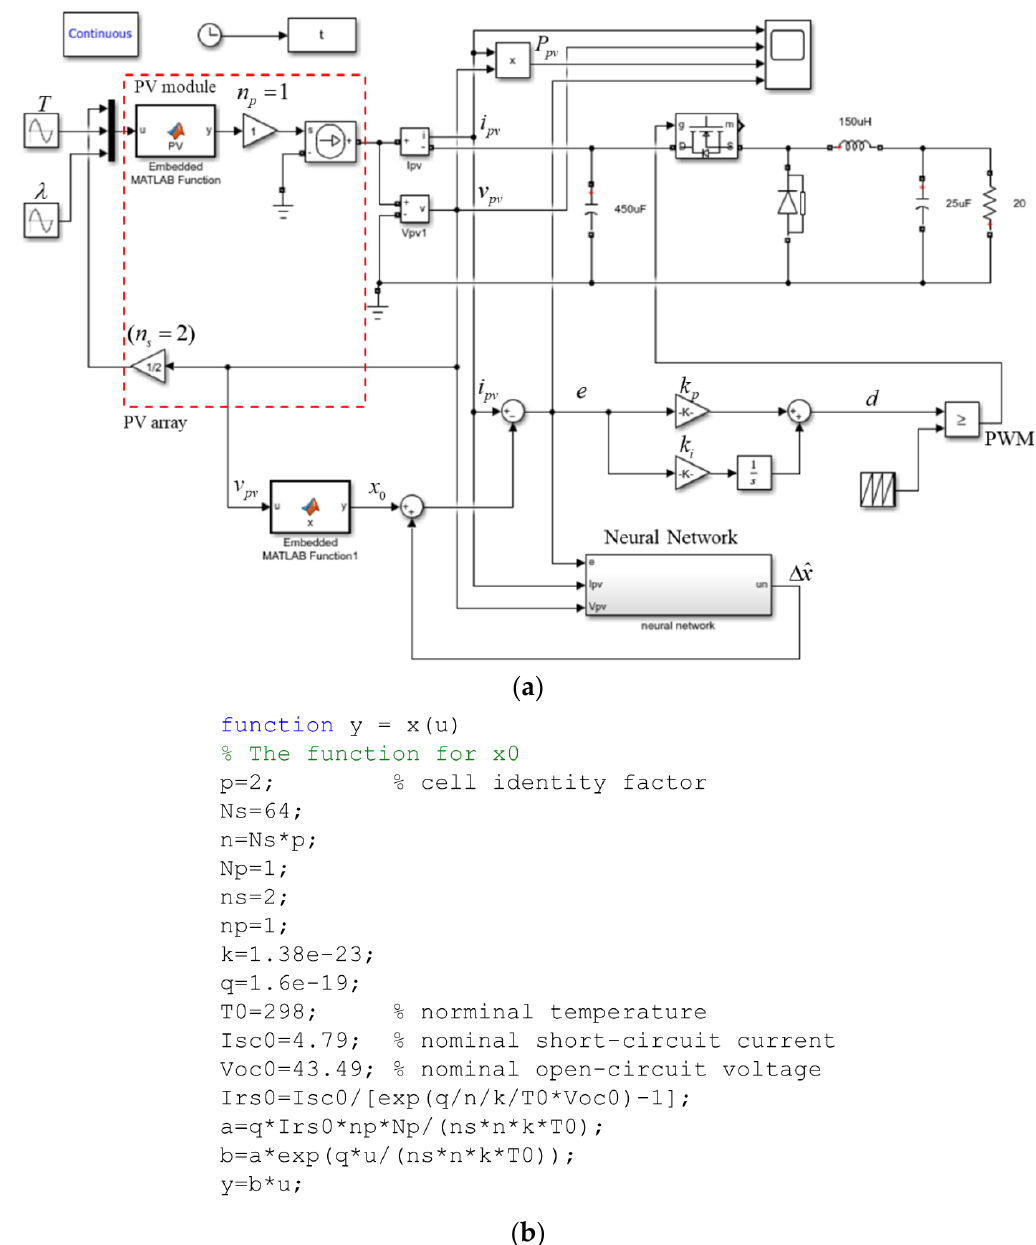
Figure 12. The simulation block construction: ( a ) PV system model, ( b ) nominal function for 0 x .